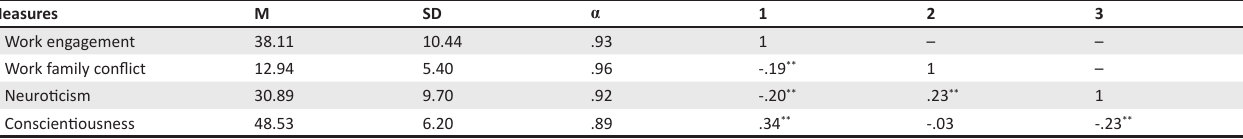
TABLE 1 : Descriptive statistics and Pearson’s intercorrelation of variables.